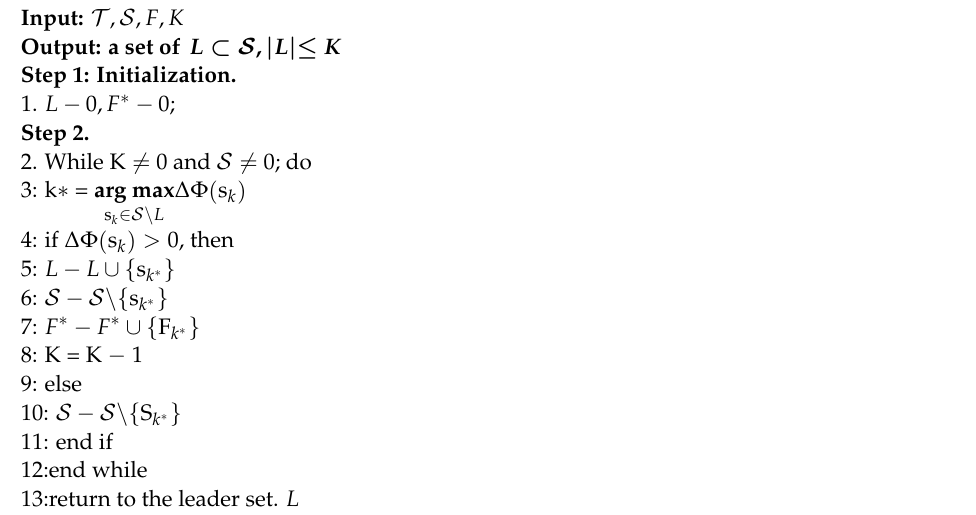
Algorithm 1: Initial leader selector Group leader